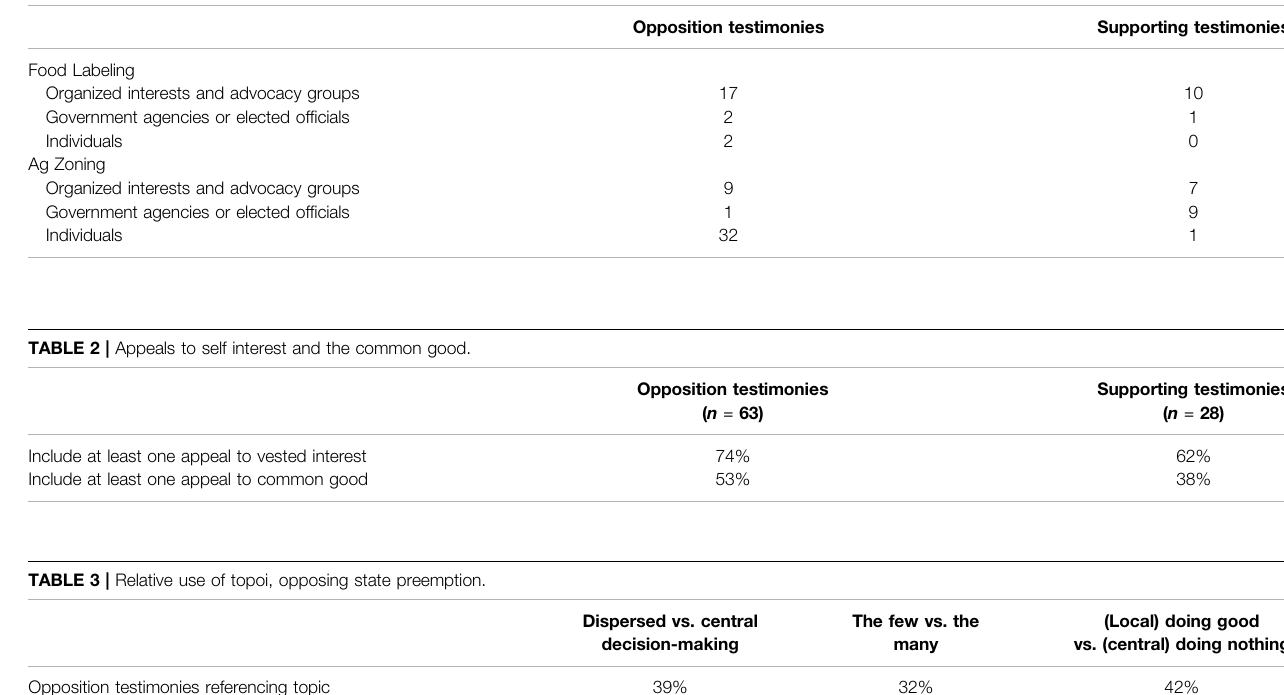
TABLE 1 | Sources testifying on preemption bills.